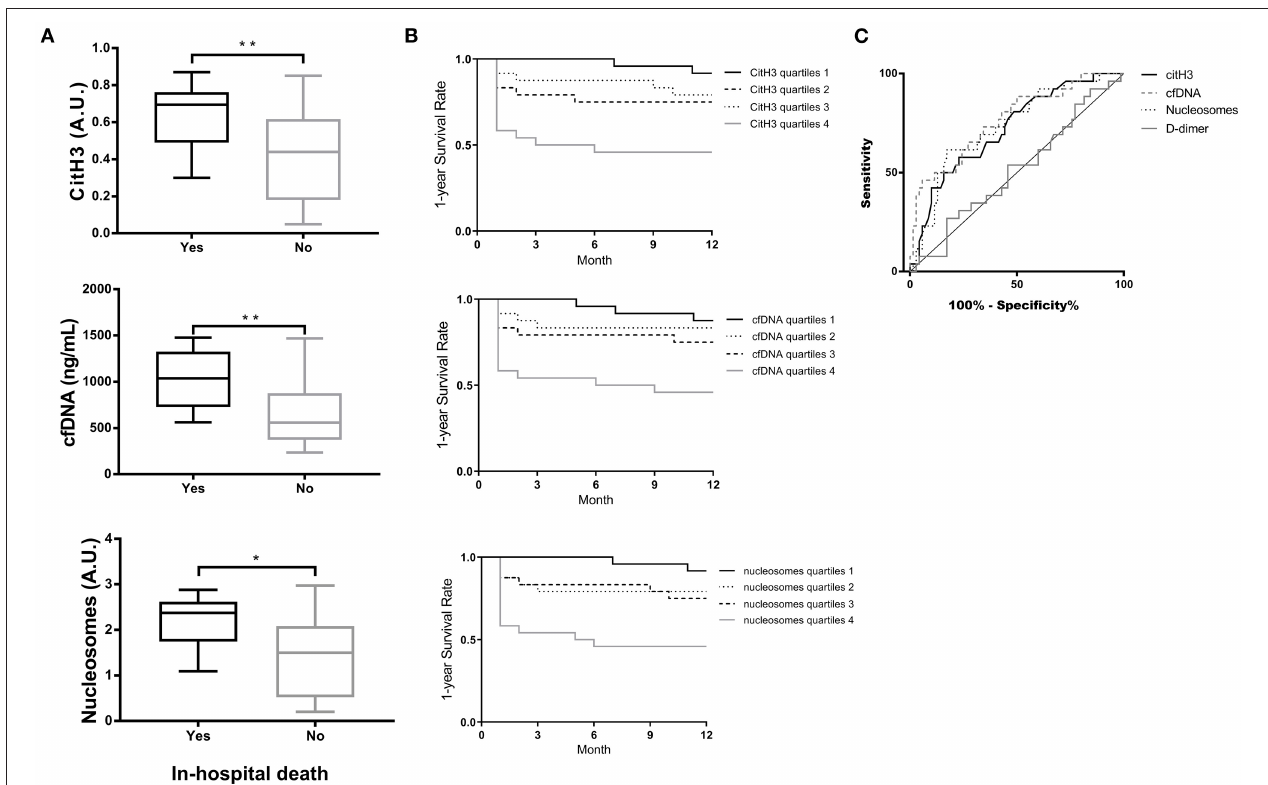
FIGURE 3 | Prognostic significance of circulating NET markers for predicting in-hospital death and 1-year survival of AAD patients. (A) Serum levels of citH3, cfDNA and nucleosomes in patients with in-hospital death were significantly higher than those in patients without in-hospital death. (B) AAD patients with the highest quartiles of citH3, cfDNA or nucleosome levels presented significantly lower survival rates by 1 year than patients with the lower three quartiles of citH3. (C) Based on the ROC curve, three circulating NET markers showed superior prediction ability of 1-year survival compared with D-dimer. * P < 0.05, ** P <